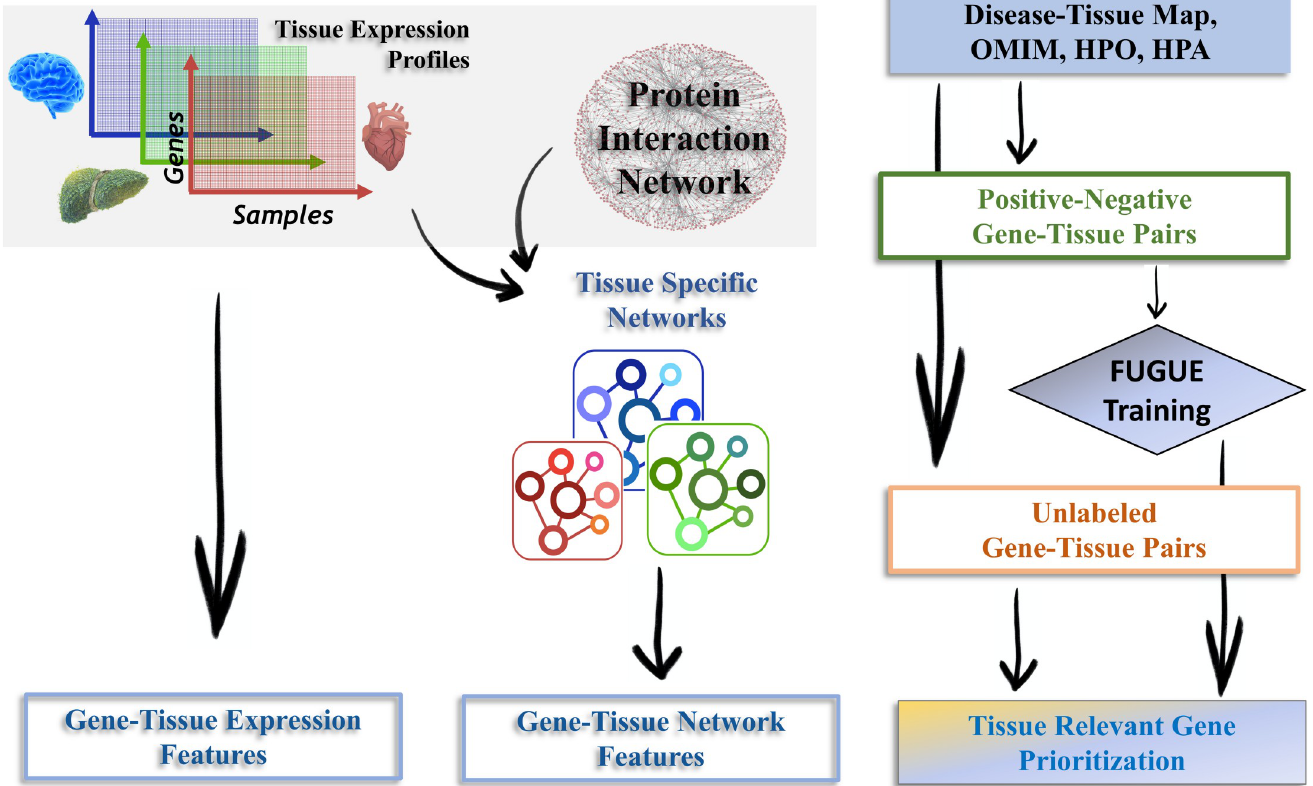
Fig 1. FUGUE Overview. Left Panel: Given multi-sample gene expression samples for a tissue, and a human protein interaction network, we derive several expression-based and network-based features for every gene. Right Panel: We compile a set of positive and negative gene-tissue pairs by integrating (i) previously curated disease-tissue map, (ii) OMIM database, (iii) HPO database, and (iv) HPA database. Using the compiled gene-tissue pairs we train a XGBOOST model and apply it to prioritize all unlabeled genes in a tissue.